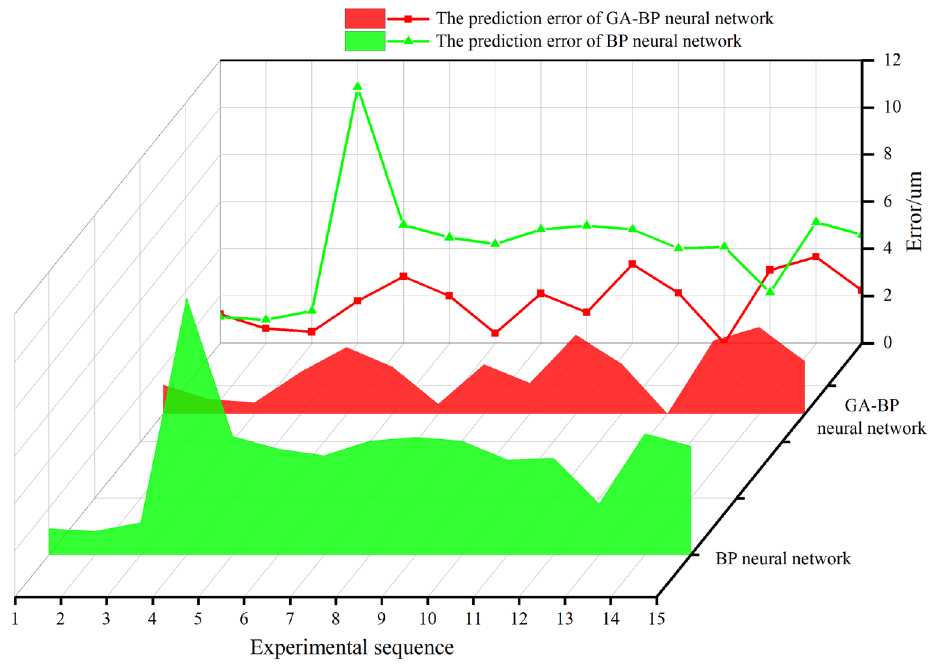
Figure 14. Model prediction error.